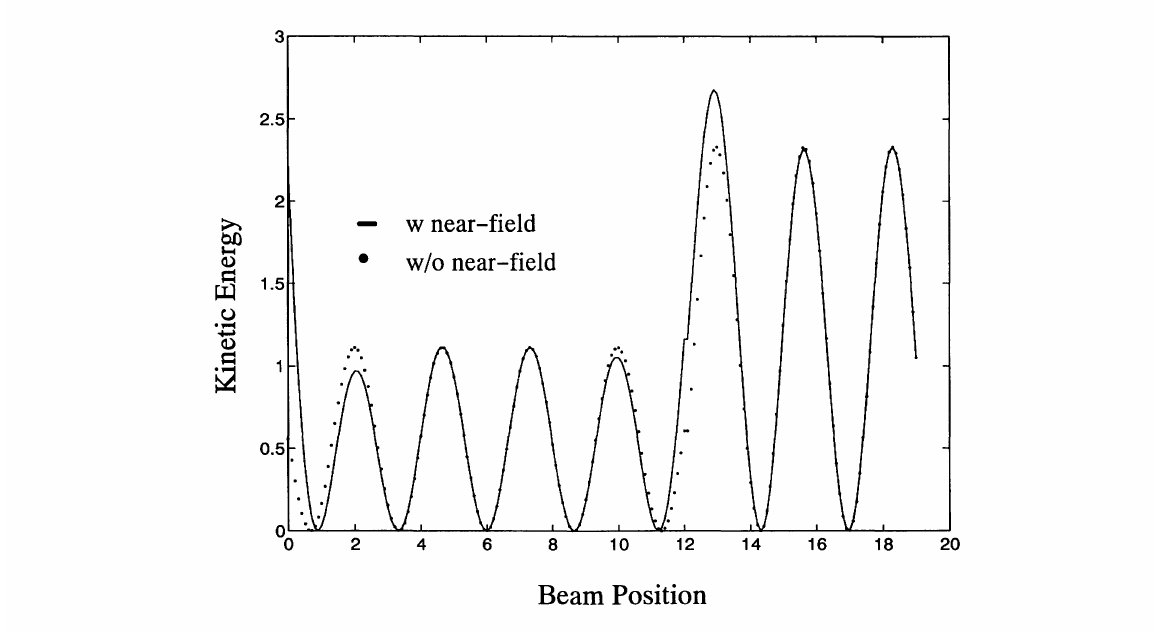
FIGURE 5 Kinetic energy with and without near-field